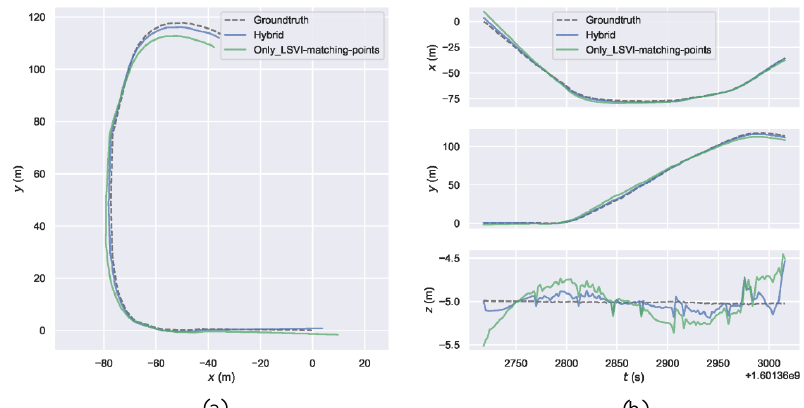
Figure 12. Quantitative comparisons of the algorithm with only LSVI matching points and the algorithm with hybrid features against the ground truth in simulation experiments: ( a ) Trajec- tory comparisons on ModernCity-downward sequence; and ( b ) Position error comparisons on ModernCity-downward sequence.